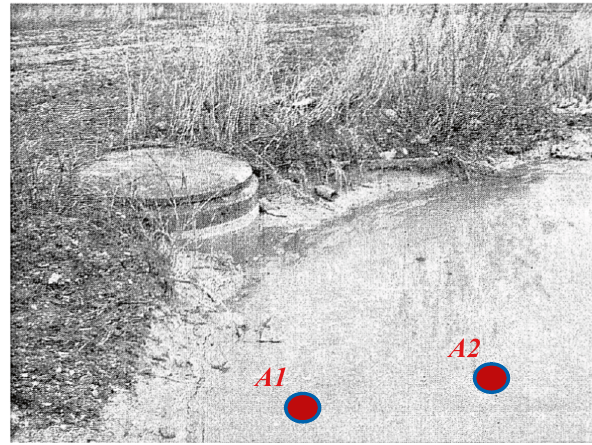
Fig. 1 Leachate from the washing area of the production